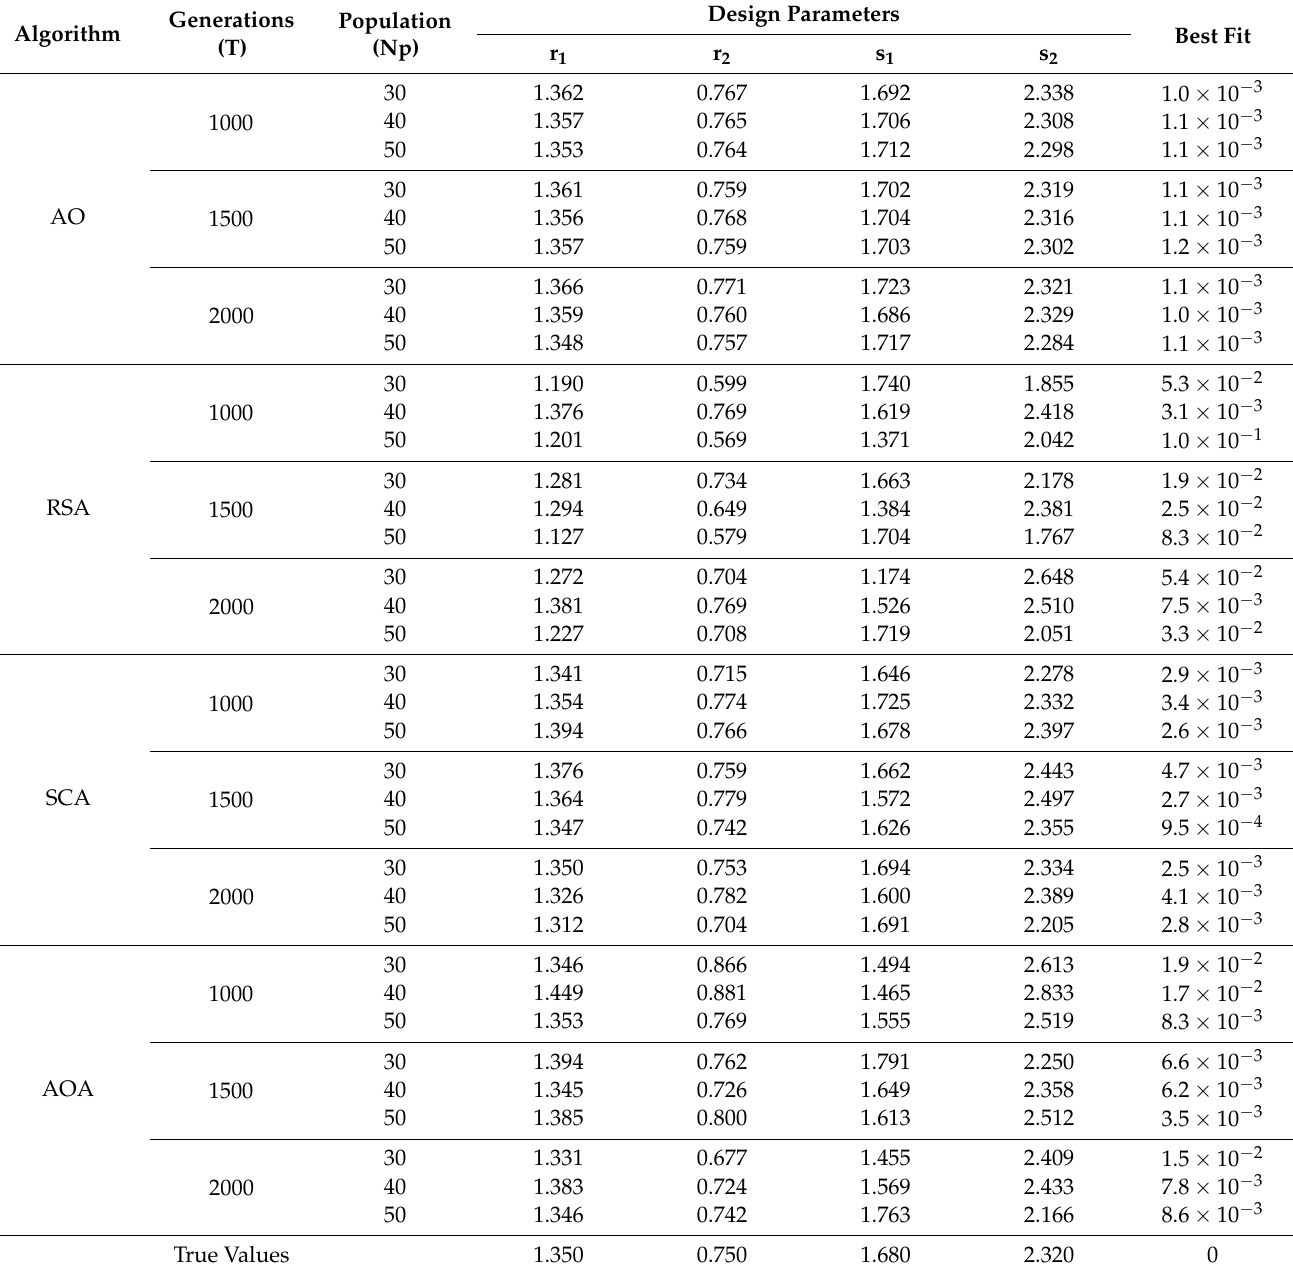
Table 15. Comparison of AO with AOA, SCA, and RSA against the true values for the CAR model at 0.04 noise